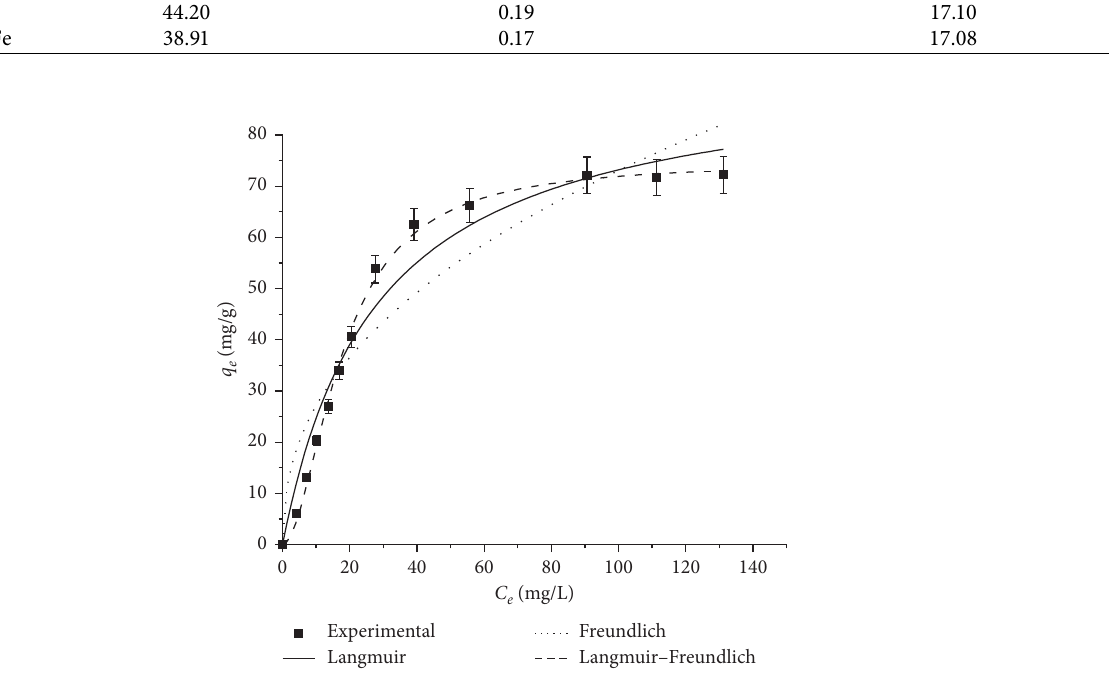
Figure 7: Fitting data of the isotherm points to Langmuir, Freundlich, and Langmuir–Freundlich Table 3: Adjustment parameters for Langmuir, Freundlich, and Langmuir–Freundlich models. Model Equation Settings